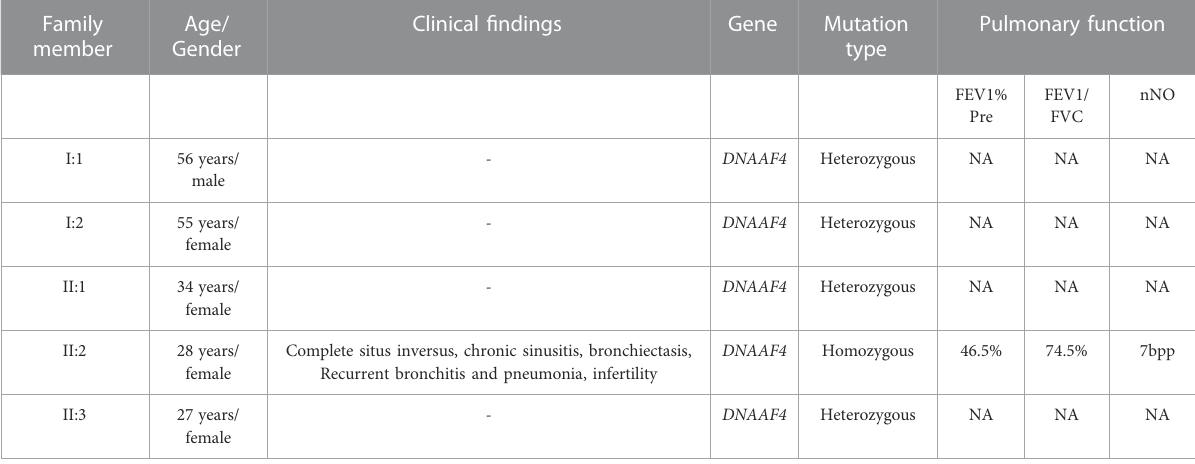
TABLE 1 Family member phenotypes and genotypes. Family